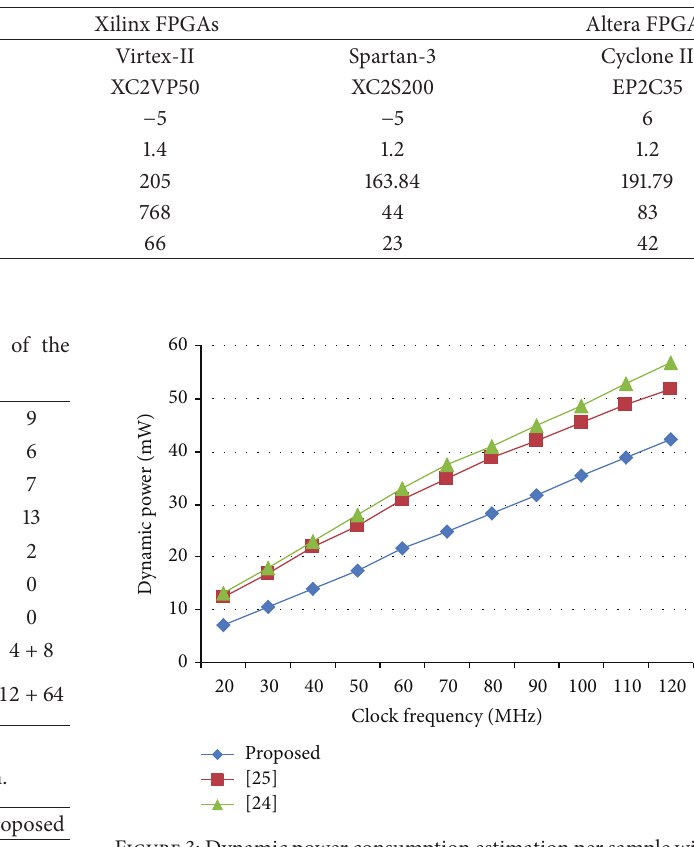
Table 5: Description of the platforms used for the experiments with power analysis.